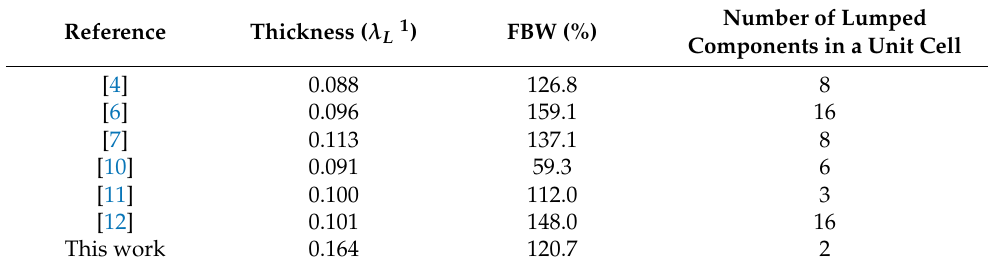
Table 1. Comparison of the proposed 3D absorber and other absorbers.